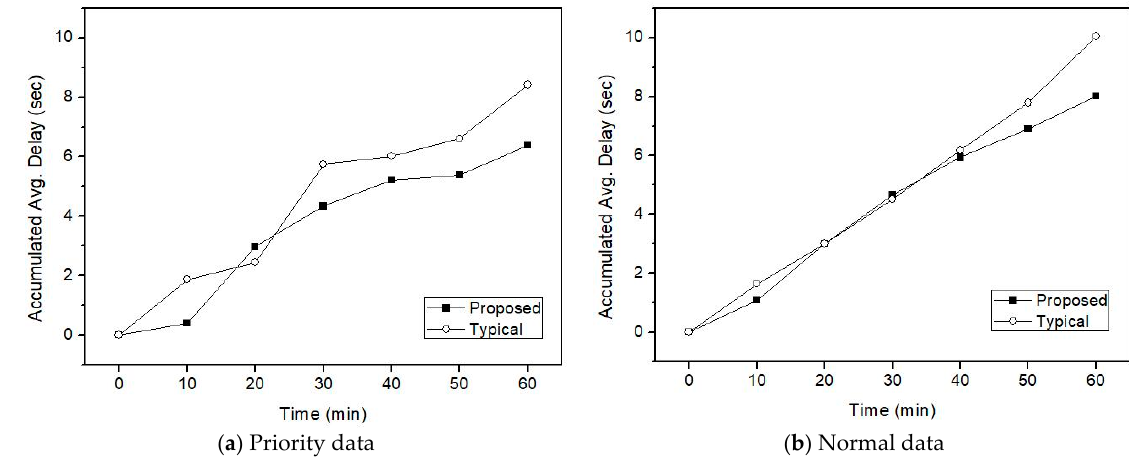
Figure 8. Transmission delay when p is 0.4 and IoV high ‐ priority is 30%.